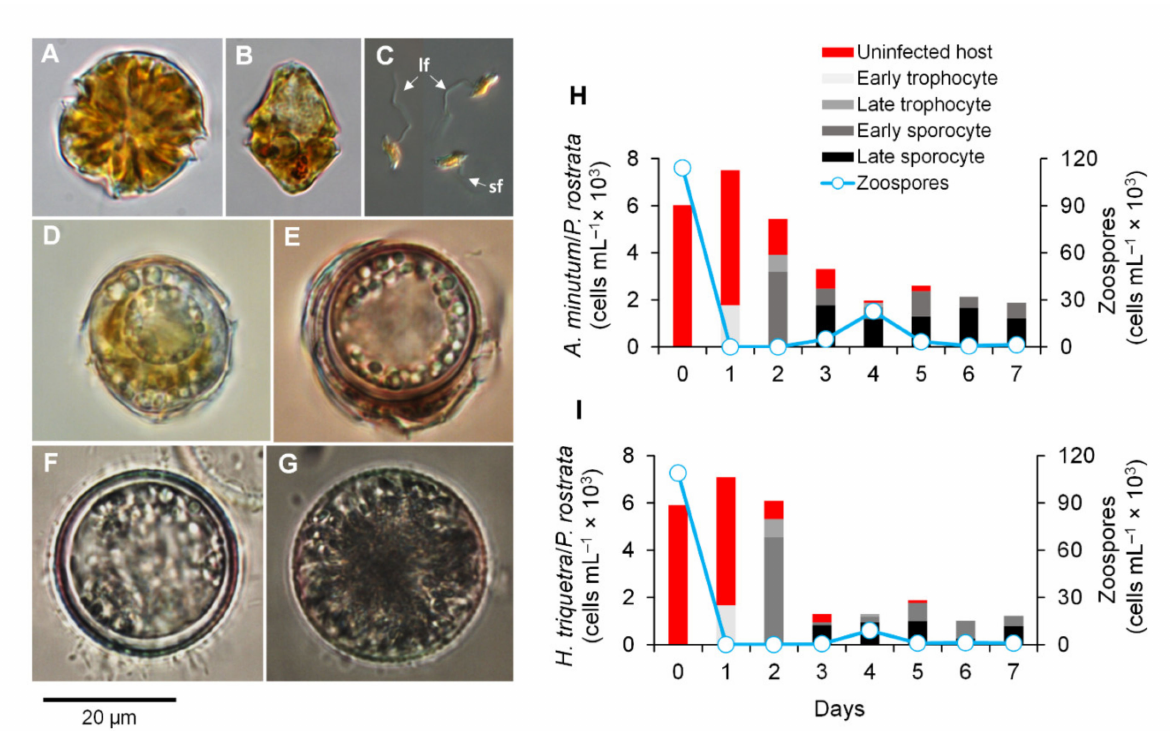
Figure 1. Dinoflagellate hosts Alexandrium minutum ( A ) and Heterocapsa triquetra ( B ). Parvilucifera rostrata stages from infections in A. minutum : zoospores ( C ) (lf = long flagellum, sf = short flagellum), early trophocyte ( D ), late trophocyte ( E ), early sporocyte ( F ), and late sporocyte ( G ); Parasitoid–host dynamics of P. rostrata RCC2823 infecting A. minutum ( H ) and H. triquetra ( I ) at 20 ◦ C. All photomi- crographs ( A – G ) are from living cells, except for zoospores ( C ) that were fixed with Lugol’s solution.